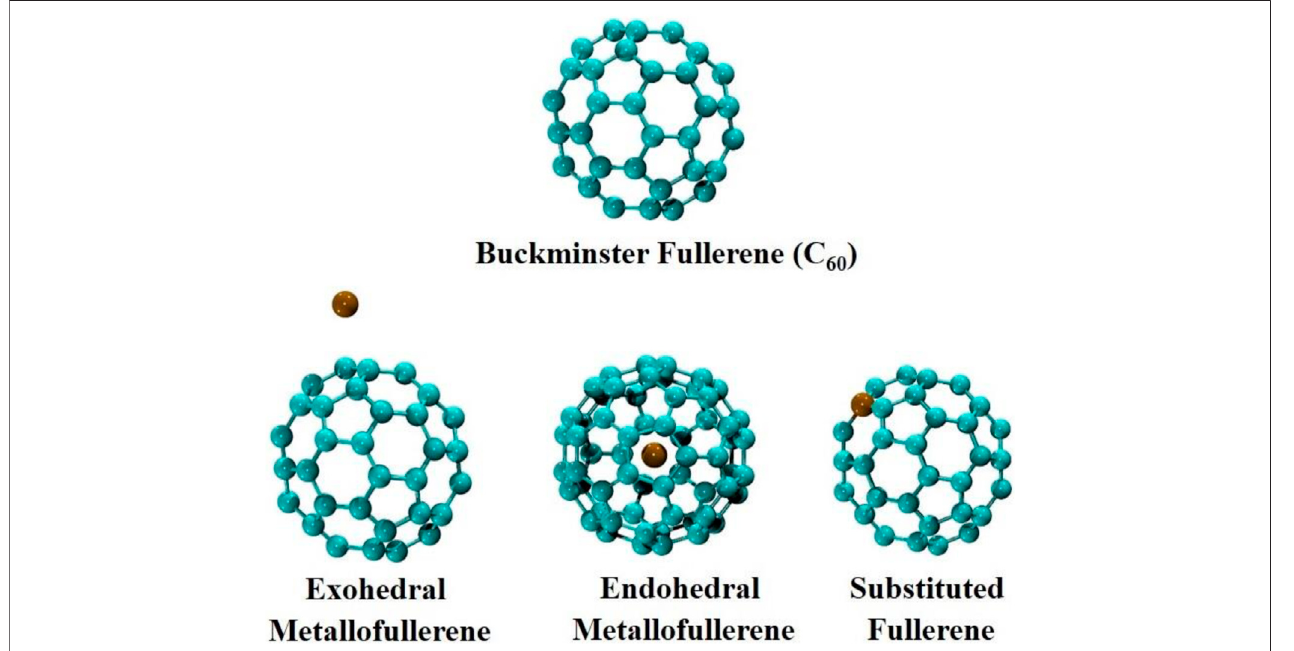
FIGURE 6 | Fullerene (C 60 ) and its three main types of